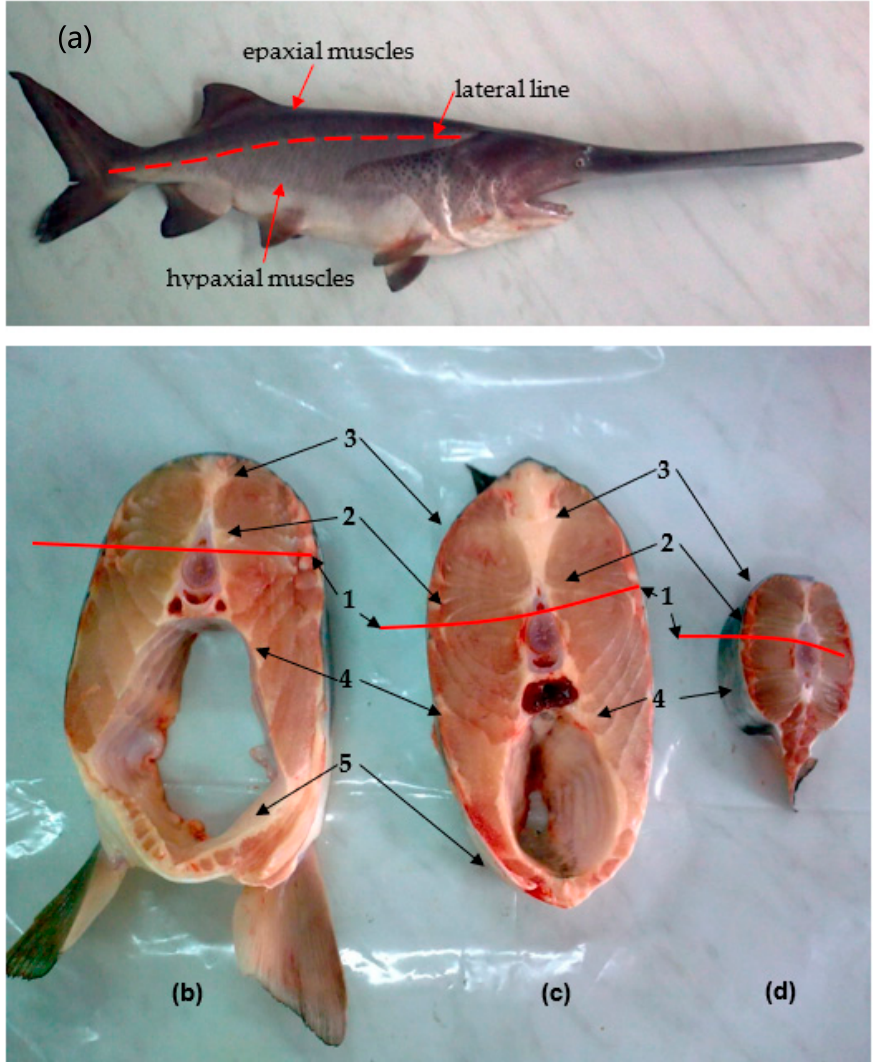
Figure 1. Side muscles in Polyodon spathula : ( a ) topographic placement; ( b , c )—cross sections through the abdominal area; ( d )—cross section through the caudally area; 1—side line; 2—costal epaxial muscles; 3—dorsal epaxial muscles; 4—costal hypaxial muscles; 5—abdominal hypaxial muscles.